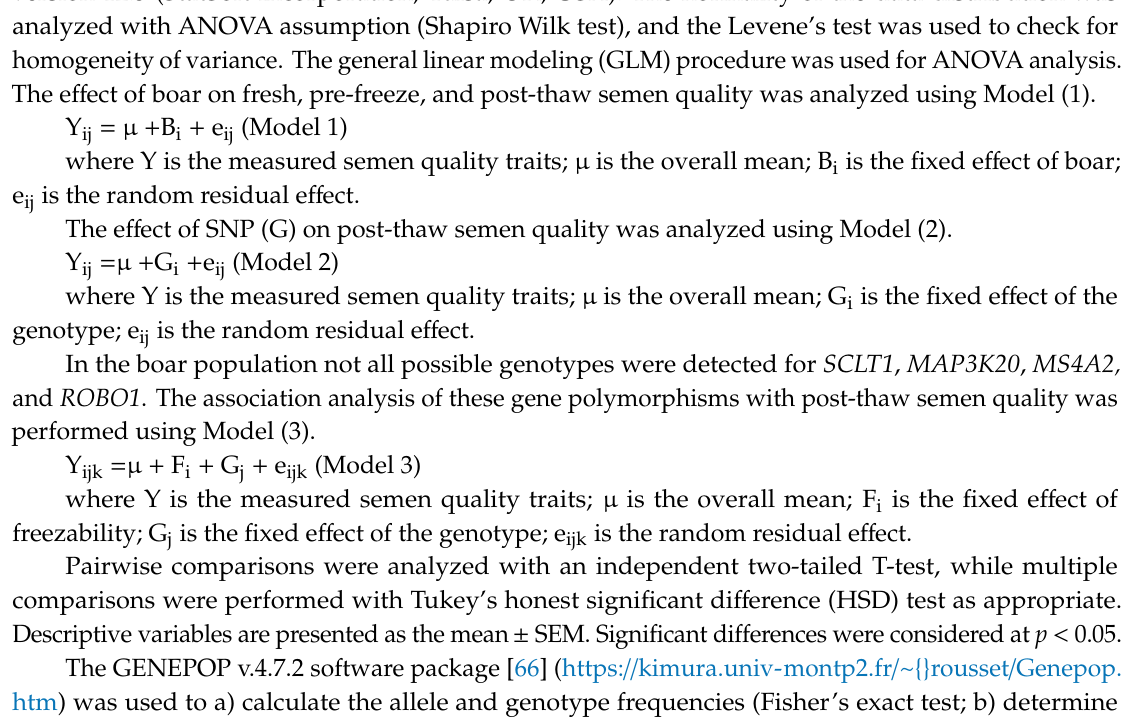
s1. Supplementary Table S1. Identification of single-nucleotide variants (SNVs) in spermatozoa boars with good candidate genes (CGs) of boar spermatozoa. Supplementary Table S3. Gene Ontology (GO) of enriched terms associated with selected candidate genes (CGs) of boar spermatozoa. Table S4. Reproductive processes, sperm functions and quantitative trait loci (QTLs) for pig reproductive traits of selected candidate genes (CGs) with single nucleotide polymorphisms (SNPs). Supplementary Table S5. Single nucleotide polymorphism (SNP) markers